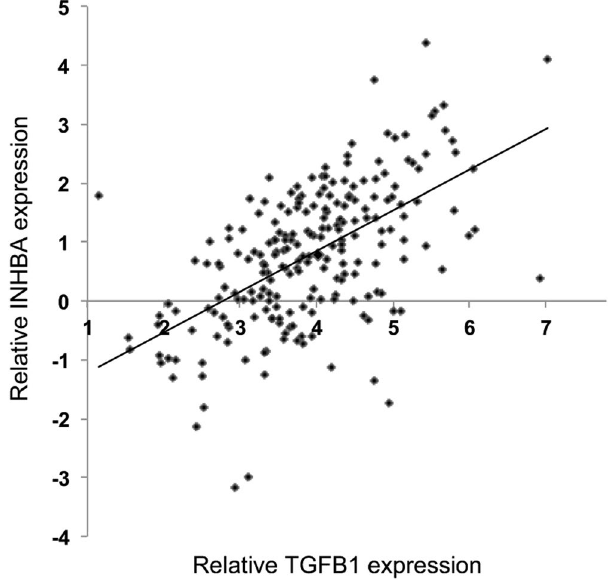
Figure 3. Activin and TGF- β ligand mRNA expression strongly correlate. Relative mRNA expression in the TCGA data set of the Activin A ligand subunit (INHBA) and TGF- β ligand (TGFB1) is shown after global normalization. Each data point represents an individual tumor (r =